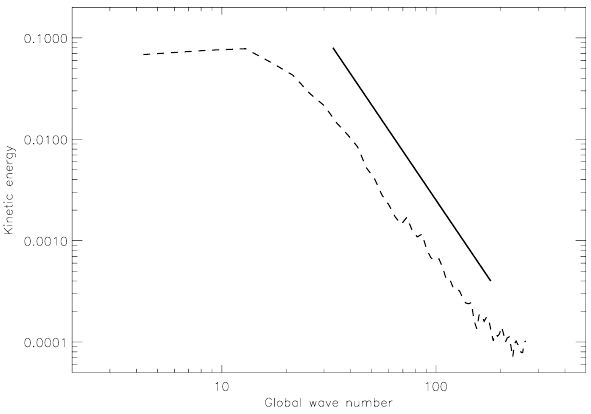
Fig. 4. The time mean kinetic energy spectrum of the high- resolution perturbation component of the truth with respect to the global wave number (dashes) in a log-log scale. The straight solid line with slope − 3 indicates the scaling law for the kinetic energy in the inertial range of two-dimensional turbulence.